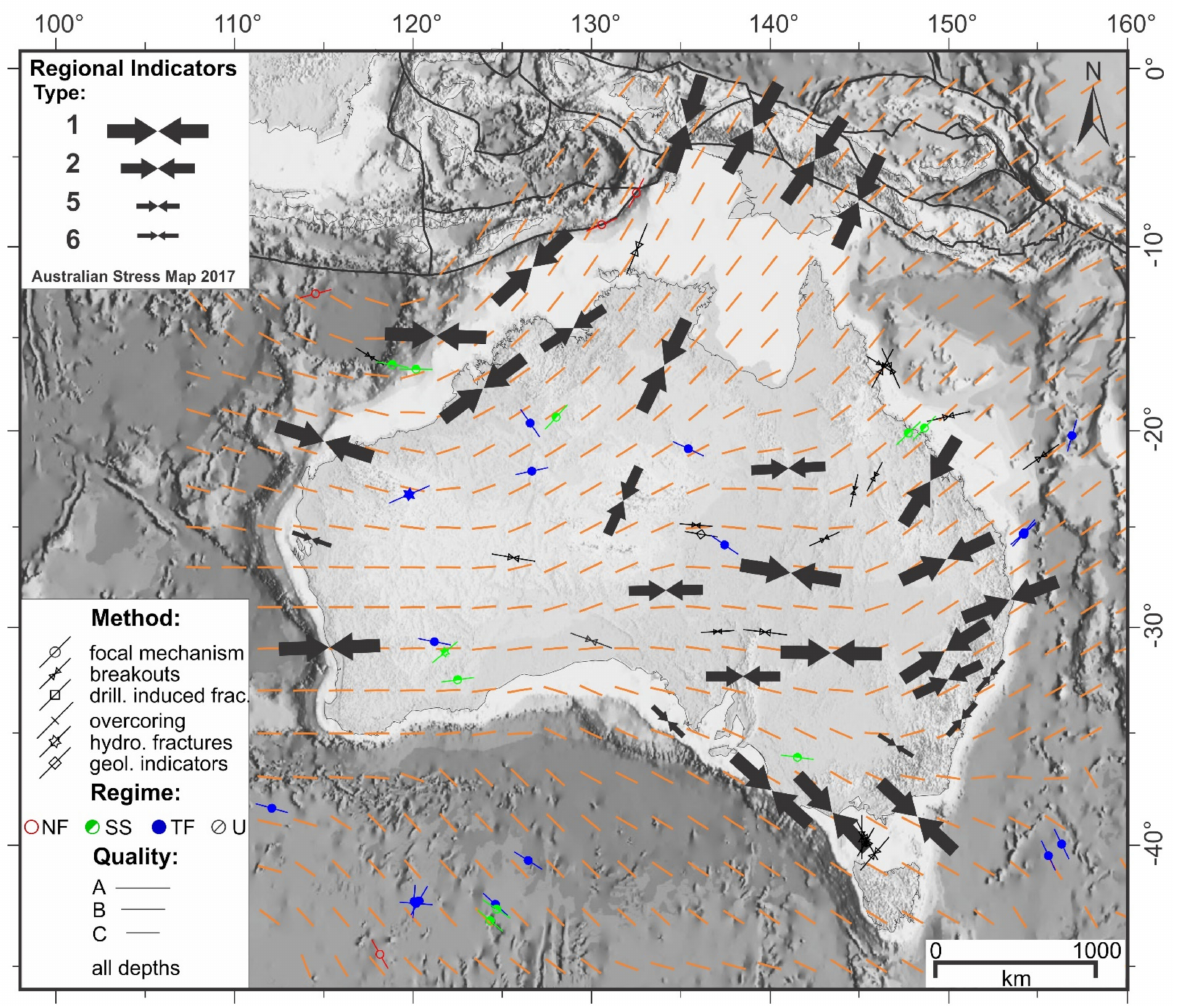
Figure 6. Stress provinces across the Australian continent [14]. The orange lines show the smoothed pattern of maximum horizontal stress (S Hmax ) that demonstrate the variability of S Hmax across the Australian